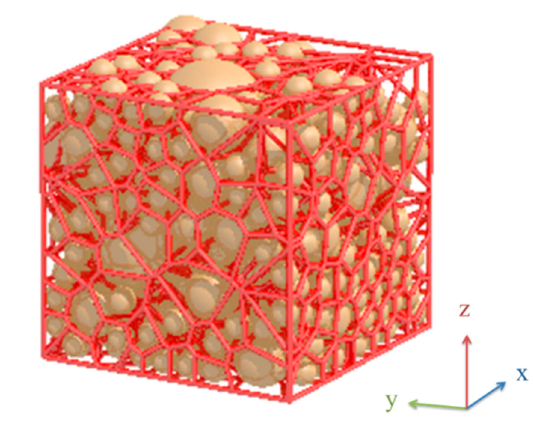
Figure 2. Illustration of typical radical Voronoi tessellation for ternary mixture with volume fraction of small, medium and large particles equal to 25%:25%:50% and particle size ratio 1:2:4.